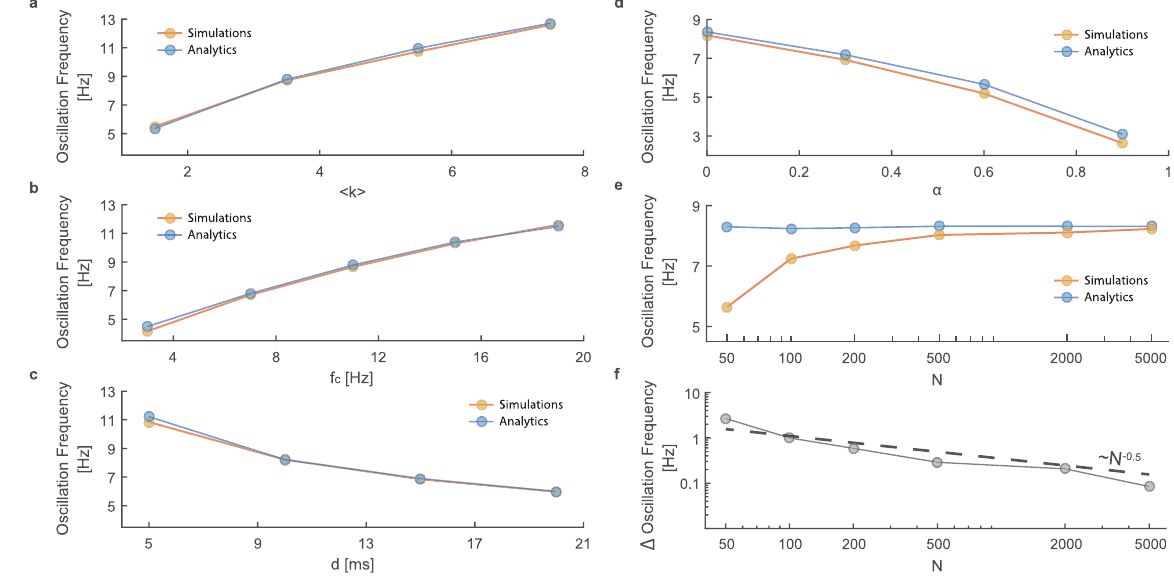
Figure 2. The oscillation frequency where only one parameter of the network is tuned (x axis). The oscillation frequency ( a ) increases with < k > , ( b ) increases with f c , ( c ) decreases with d and ( d ) decreases with α . ( e , f ) Decreasing the size of the network results in finite size effects, which decreases as N − 0 . 5 , the quantity presented in ( f ) is the difference between the two curves from ( e ). Each data point is the average of 10 different trials where the standard deviations are smaller than the circles. The oscillation frequency was defined as the maxima of the smoothed power spectrum (convoluted with a rect(f/1 Hz) function) per trial, with a duration of 210 seconds, where the first 10 seconds were neglected